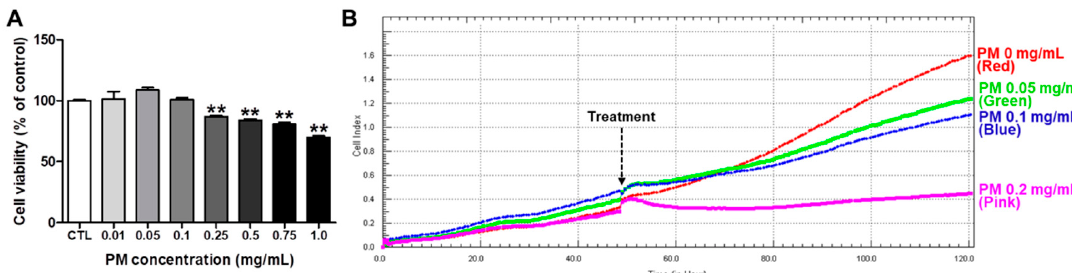
Figure 1. Cytotoxicity of PM in HepG2 cells. ( A ) HepG2 cells were treated with PM at the indicated concentrations for 24 h, and cell viability was measured by MTT assay. Data are the mean ± SEM from three independent experiments. ** p < 0.01 vs. CTL (control group). ( B ) The cells were seeded in E-plate 16, and proliferation, migration, and adherence were monitored every 15 min in the real time cell analyzer (RTCA) for 48 h. When the cells reached the logarithmic growth phase, PM was treated at the concentrations of 0, 0.05, 0.1, or 0.2 mg/mL in quadruplicate, and cell viability was monitored by continuous impedance recording every 15 min in RTCA.